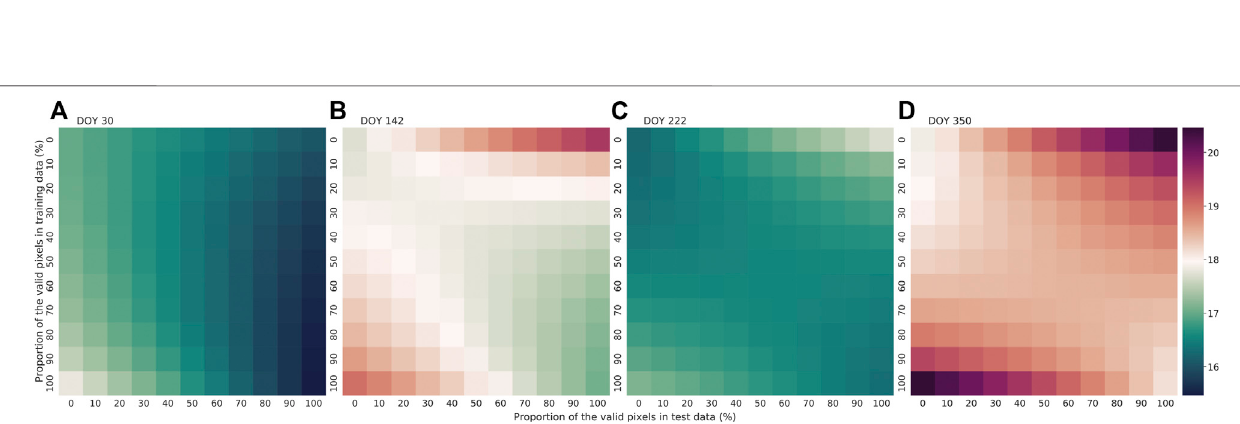
Frontiers in Remote Sensing |